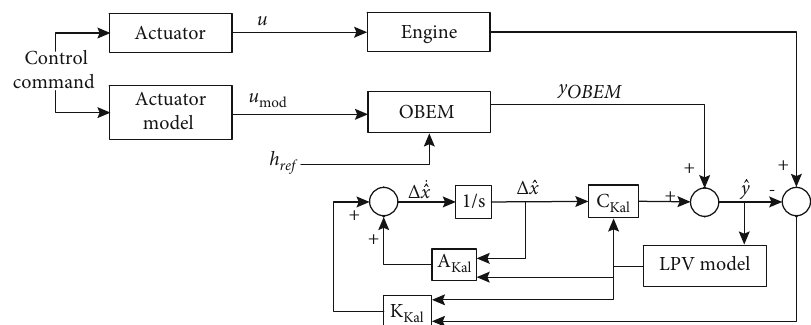
Figure 6: Structure of the